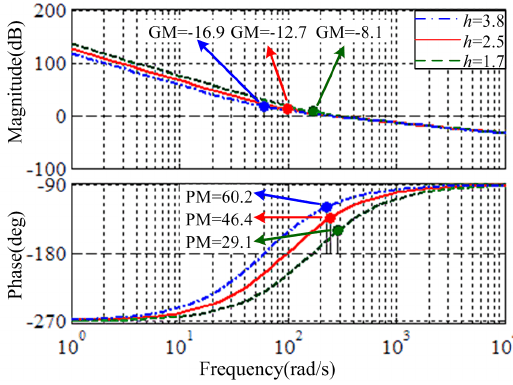
Figure 8. Open-loop bode plots of the proposed PLL.